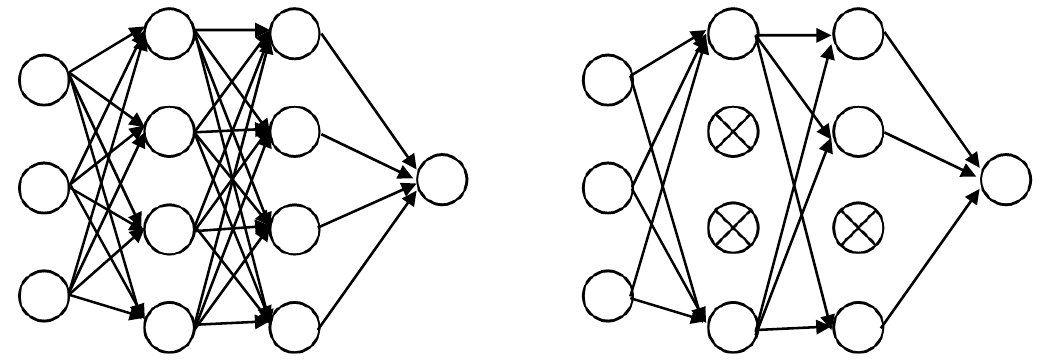
Figure 9. The technical diagram of dropout.